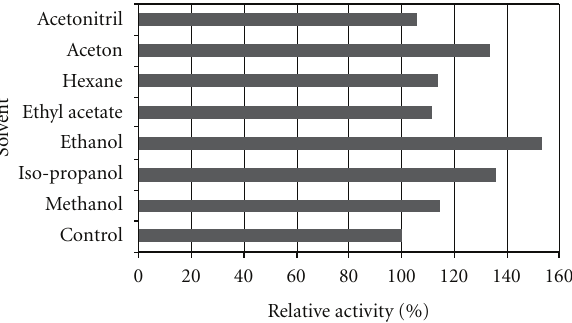
Figure 5: E ff ects of various organic solvents on Acinetobacter sp. lipase activity. The enzyme was preincubated for 30min at 30 ◦ C with 30% v/v of solvents with 150 rpm agitation. The lipolytic activity was measured at 65 ◦ C relative to the control (without solvent), using olive oil (emulsified, 1 :1 v/v, in 50mM Tris-HCl bu ff er, pH 8.0) as